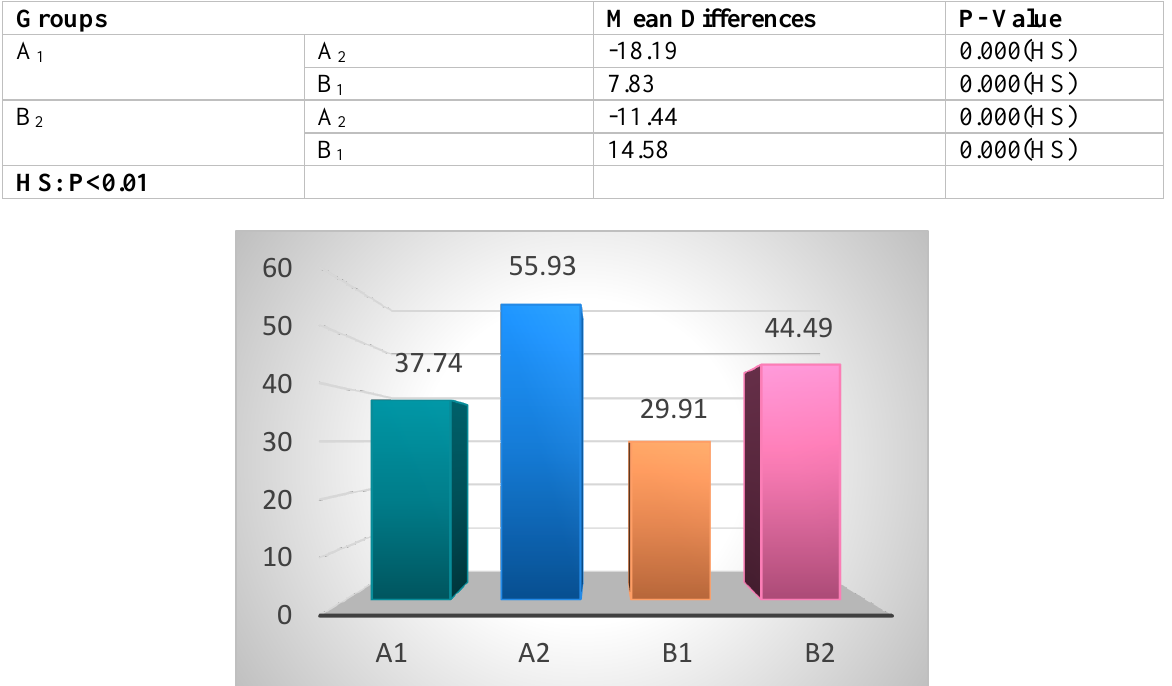
Table 3: LSD test for comparison of significance between subgroups. Groups